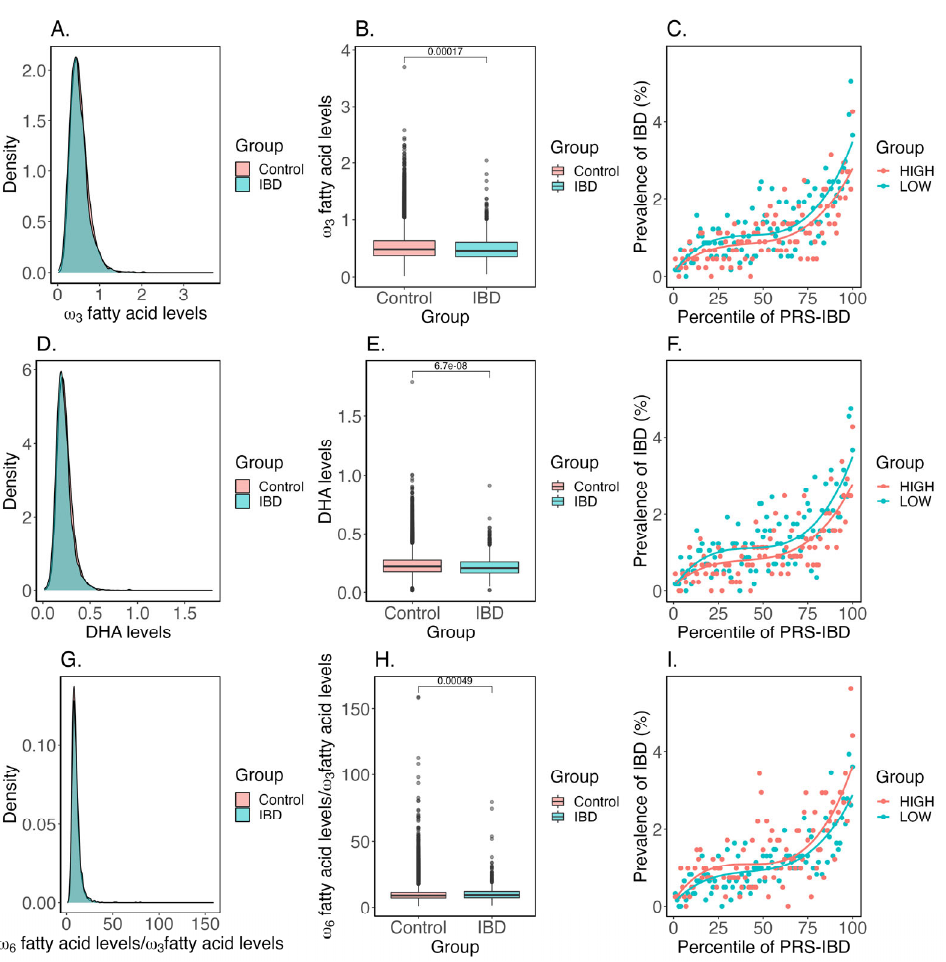
Figure 4. ( A ) Density plot comparing IBD case vs. control ω 3 fatty acid levels. ( B ) Box plot comparing IBD case vs. control ω 3 fatty acid levels. The number above the boxes represents the Welch’s t ‐ test p ‐ value. ( C ) The prevalence vs. risk of IBD for high vs. low ω 3 fatty acid levels. ( D ) Density plot comparing IBD case vs. control DHA levels. ( E ) Box plot comparing IBD case vs. control DHA levels. The number above the boxes represents the Welch’s t ‐ test p ‐ value. ( F ) The prevalence vs. risk of IBD for high vs. low DHA levels. ( G ) Density plot comparing IBD case vs. control ω 6 fatty acid to ω 3 fatty acid ratio. ( H ) Box plot comparing IBD case vs. control ω 6 fatty acid to ω 3 fatty acid ratio. The number above the boxes represents the Welch’s t ‐ test p ‐ value. ( I ) The prevalence vs. risk of IBD for high vs. low ω 6 fatty acid to ω 3 fatty acid ratio.